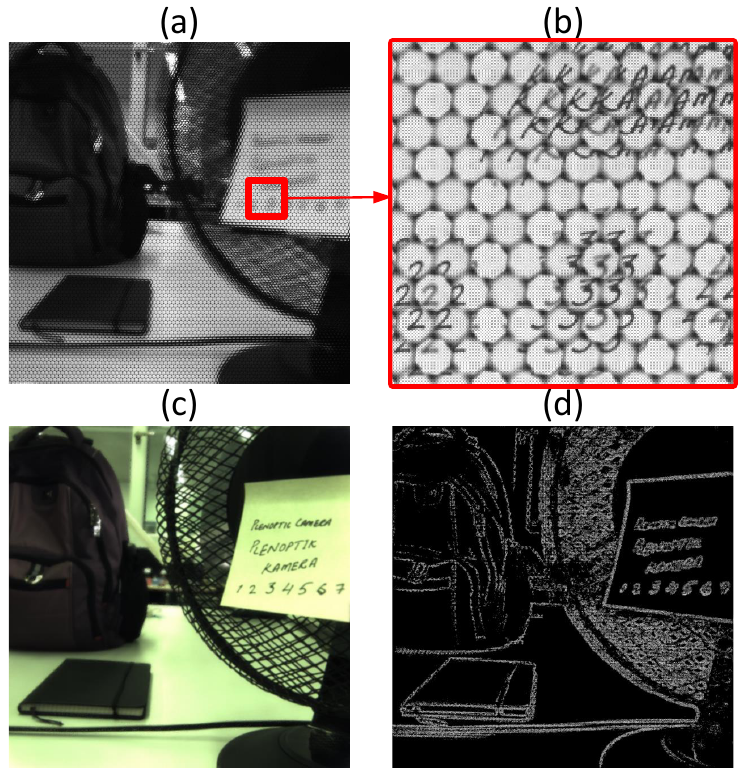
Figure 2. ( a ) Raw image captured by plenoptic camera ( b ) part of the image displaying micro-images ( c ) resulting image after applying refocusing ( d ) estimated sparse depth map of the